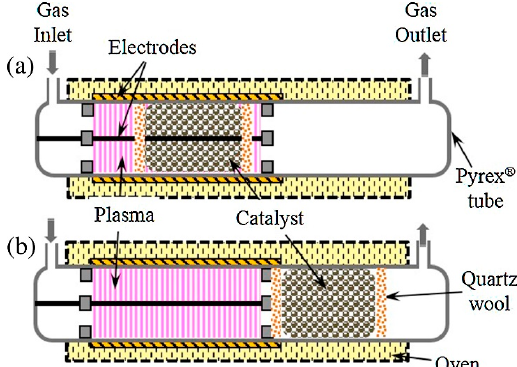
Figure 1. The working principle of the continuous adsorption-plasma catalytic process for volatile organic compounds (VOCs) removal ( a ) in-plasma catalysis and ( b ) post-plasma catalysis. Reprinted from Reference [40], with permission from